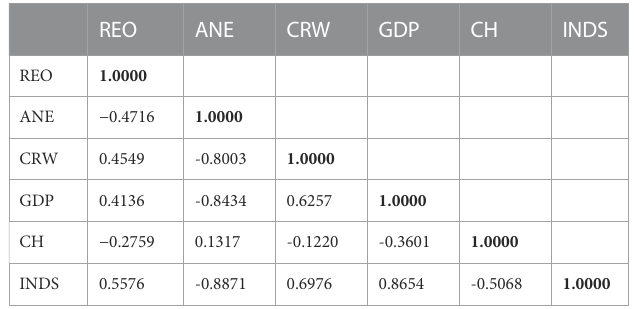
TABLE 4 Statistical description of variables. TABLE 5 correlation